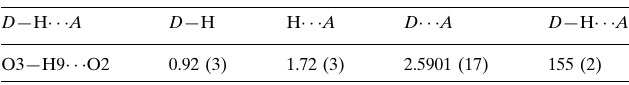
Hydrogen-bond geometry (A˚ , (cid:1) ).